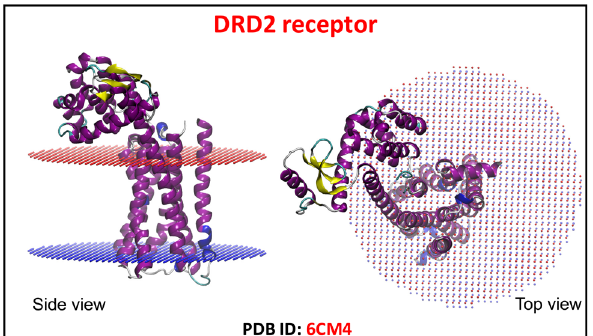
Figure 1: The DrD2 receptor [ 15 ] embedded in the POPC membrane. Upper and lower membrane planes are depicted in red and blue,